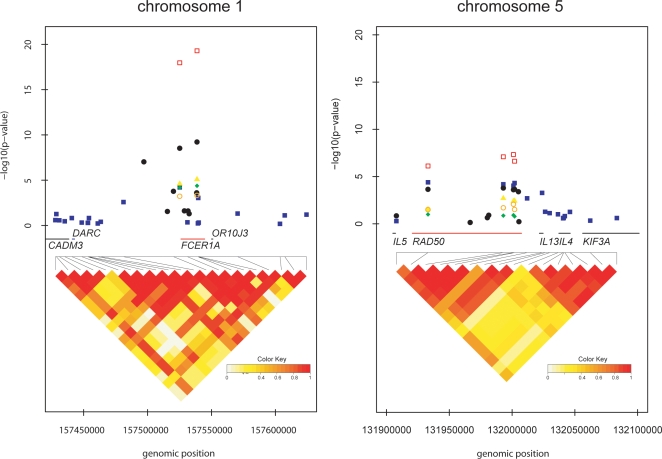
P value and pairwise linkage disequilibrium diagram of the region on chromosome 1q23, area of FCER1A (panel A), and chromosome 5q31, area of RAD50 (panel B).Pairwise LD, measured as D', was calculated from KORA S3/F3 500 K. Shading represents the magnitude of pairwise LD with a white to red gradient reflecting lower to higher D' values. Gene regions are indicated by colored bars. P value diagram: The x-axis represents the genomic position. The y-axis shows −log10 (P values) of KORA S3/F3 500 K (blue), KORA S4 (black), GINI (yellow), LISA (green), ISAAC (orange), combined replication samples (red).